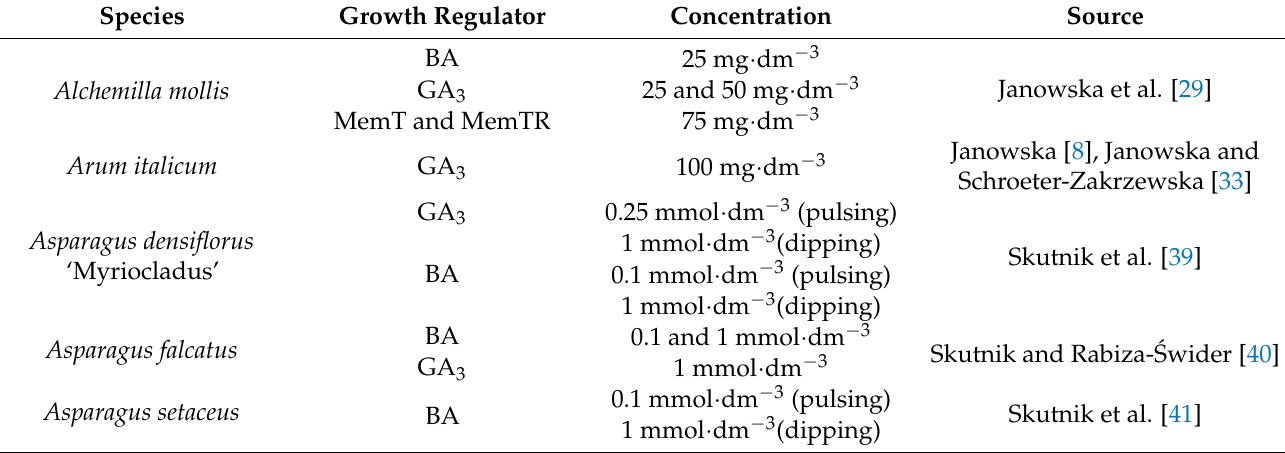
Table 2. Growth regulators that are used to extend the vase life of florists’